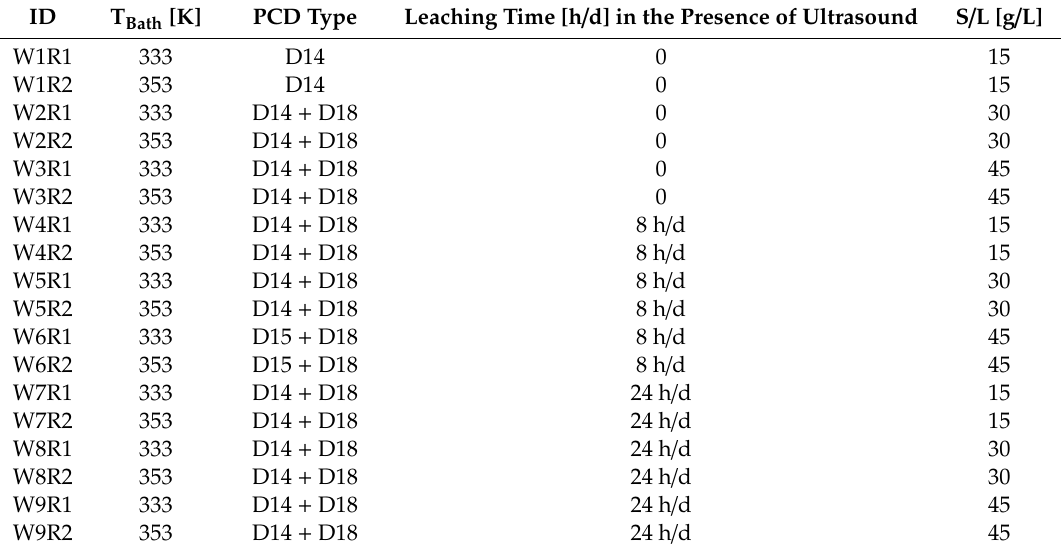
Table 3. Parameters for the leaching of cobalt from polycrystalline diamond